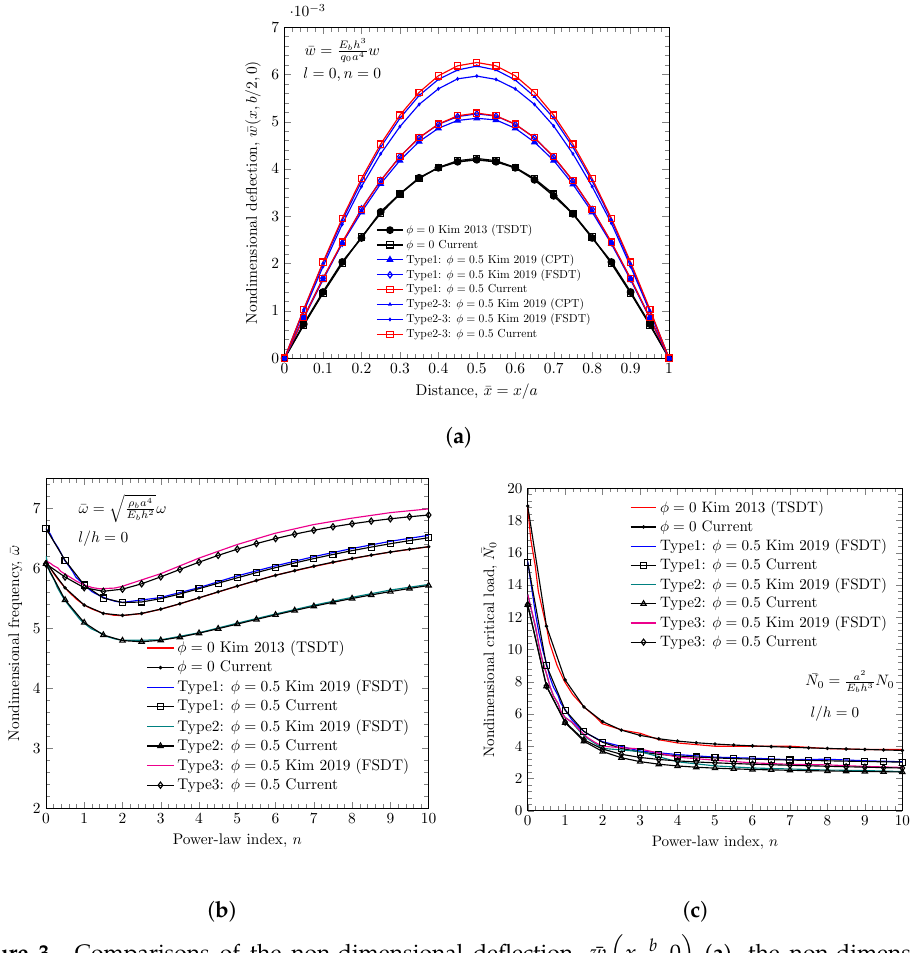
Figure 3. Comparisons of the non-dimensional deflection, ¯ w fundamental frequency, ¯ ω ( b ), and the non-dimensional critical buckling load, ¯ N 0 ( c